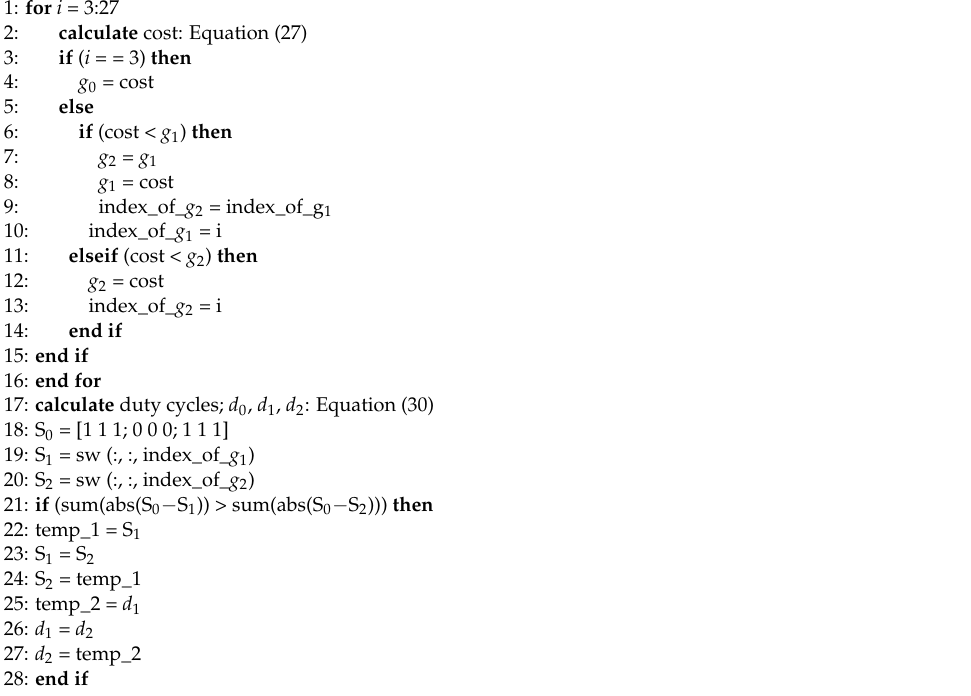
Algorithm 1 The routine for selecting the best two switching states and calculating the associated duty